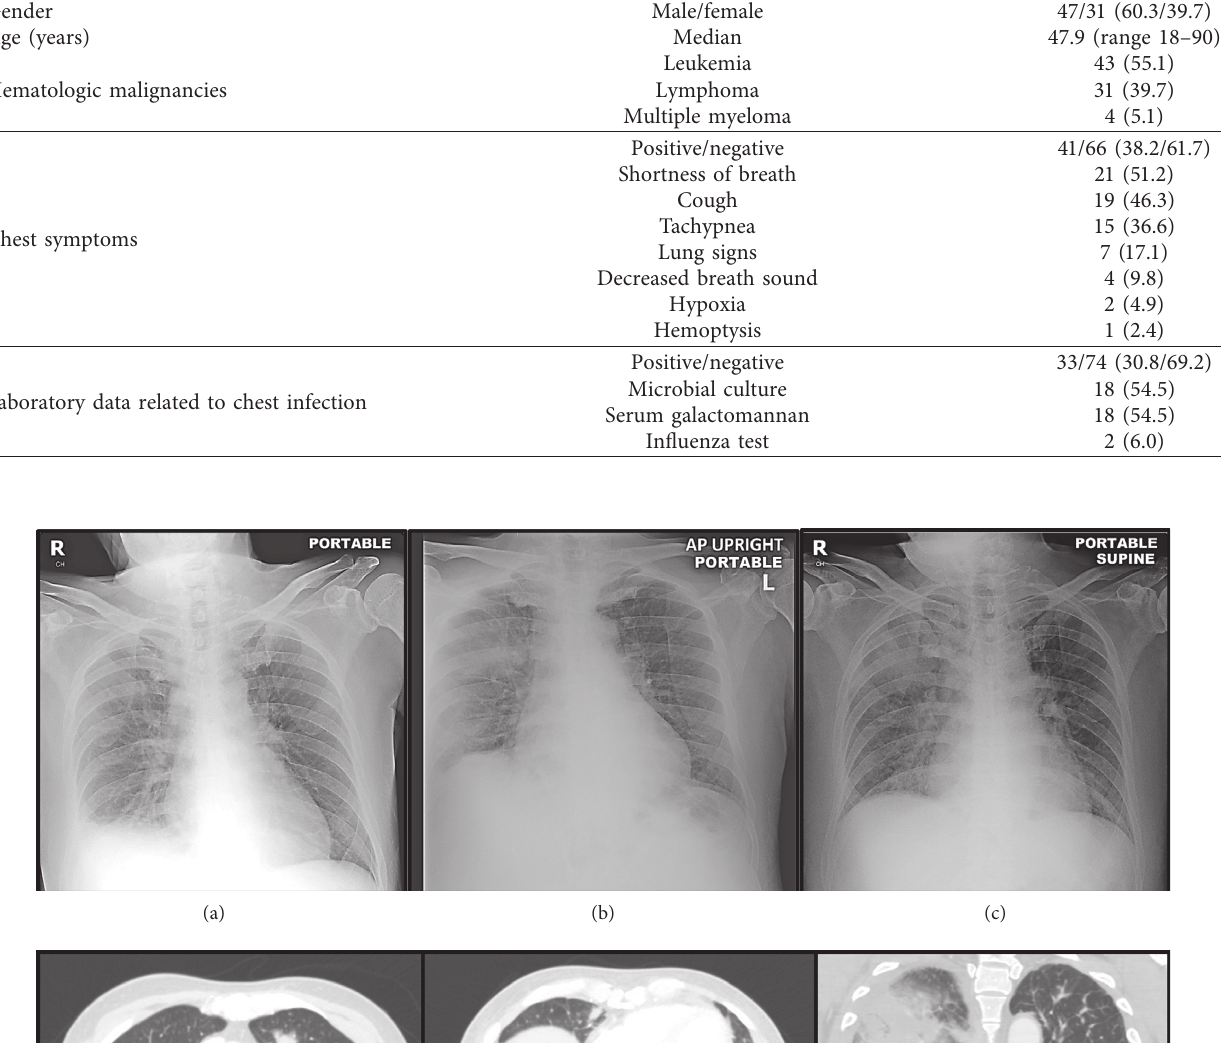
Table 1: Baseline characteristics of the patients, including details of chest symptoms and laboratory data related to chest infection. Baseline characteristic